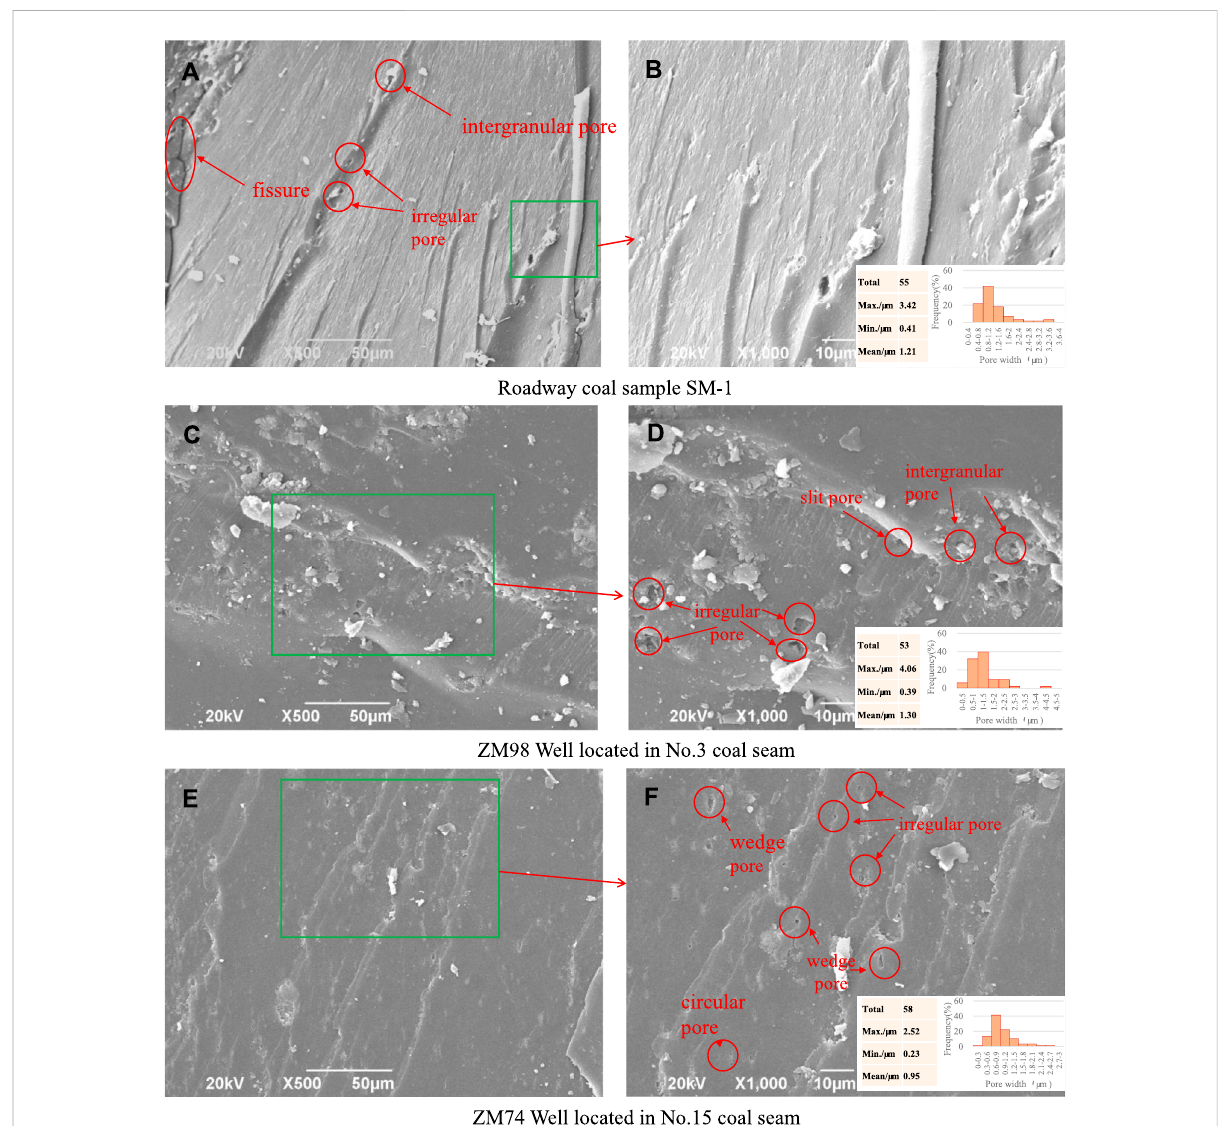
FIGURE 3 SEM of coal